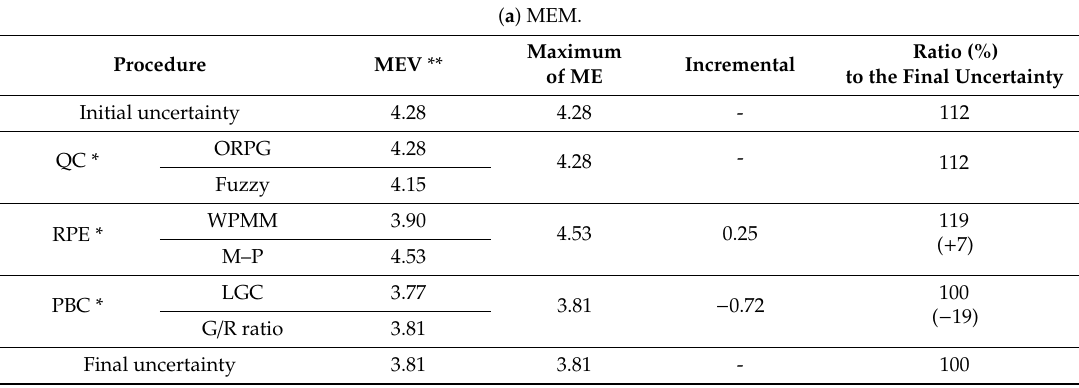
Table 3. Comparison of uncertainty quantification results for each stage in the radar-based precipitation estimation process using the MEM, UDM, and